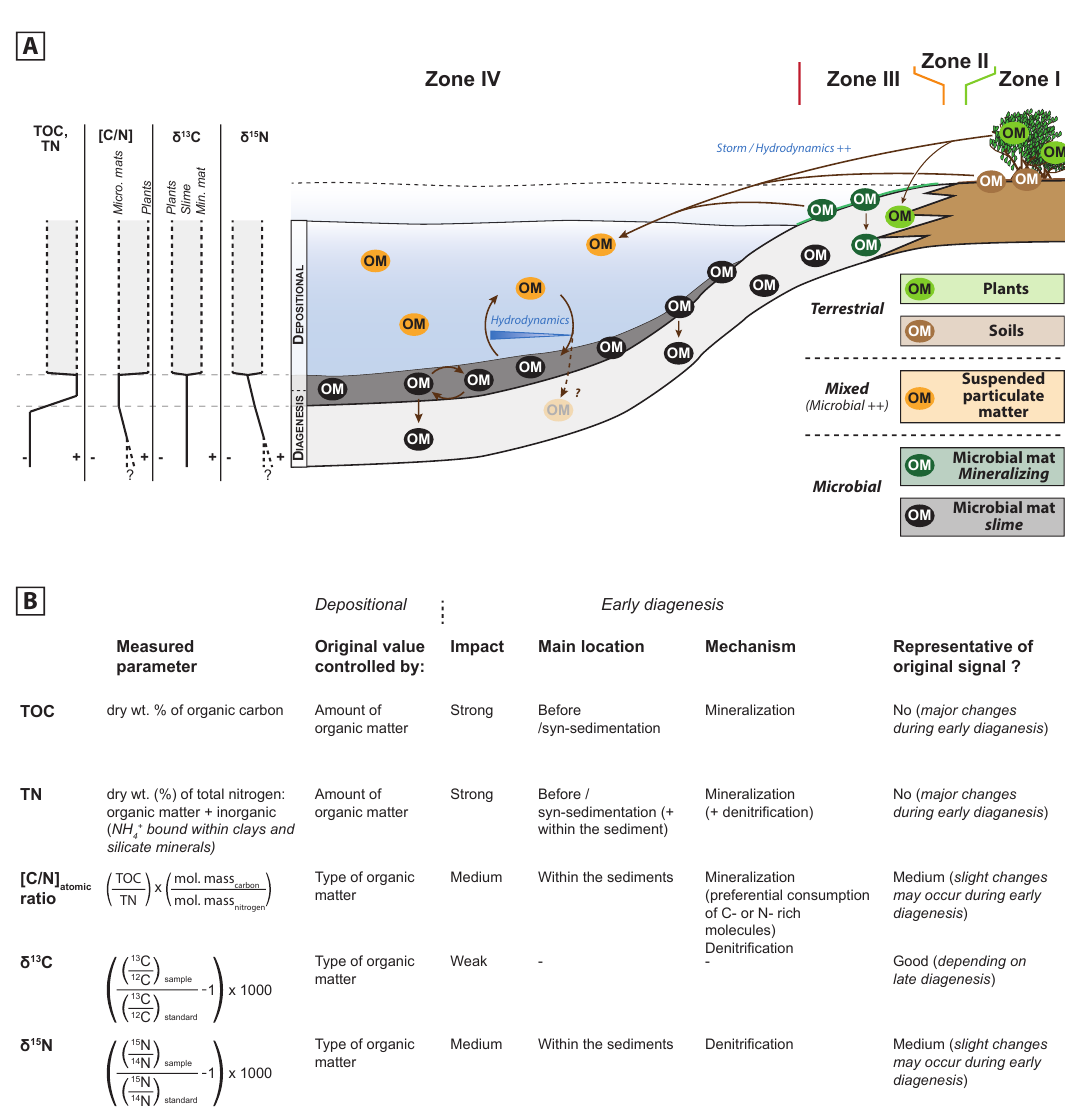
Figure 7. ( A ) Synthetic cartoon representing the organic matter dynamics in the easternmost lagoon of the Cayo Coco lagoonal network. The organic matter preserved within the sediments (micritic muds and bioclastic sands, in grey) only corresponds to a very small fraction of the organic matter present in the system. Most of this preserved organic matter depicts an elemental and isotopic signature close to the microbial slime, which appear to be the dominant source. Locally, other potential organic matter sources (e.g., mineralising microbial mats and plant fragments) can have a greater influence. The organic matter in the form of suspended particulate matter may originate from the remobilisation of the slime originally present at the bottom of the lagoon or the supply of organic matter outside the lagoon (e.g., plant fragments, soils) during high hydrodynamic episode (e.g., storm). ( B ) Synthesis of the elemental (TOC, TN and [C / N] atomic ratio) and isotopic ( δ 13 C org and δ 15 N TN ) signals during deposition and early diagenesis and their ability to be used to decipher the original organic matter source(s). (i) Pace et al. [30] documented the processes and products of mineralisation during the early development of these hypersaline microbial mats composed of three di ff erent laminae (green, white and red). Oxygenic photosynthesis predominates over aerobic respiration in the surface green lamina of the mat, where Mg-silicate globules precipitate in the EPS matrix, often in close association with coccoid cyanobacterial clusters. In this zone, the EPS bind calcium, thus inhibiting carbonate precipitation. Anoxygenic photosynthesis which occurs due to the presence of purple sulphur bacteria (PSB)